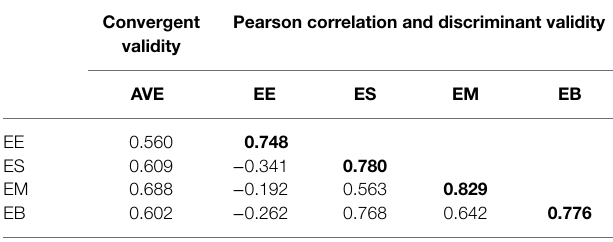
TABLE 2 | Validity test of the questionnaire. Convergent Pearson correlation and discriminant validity validity